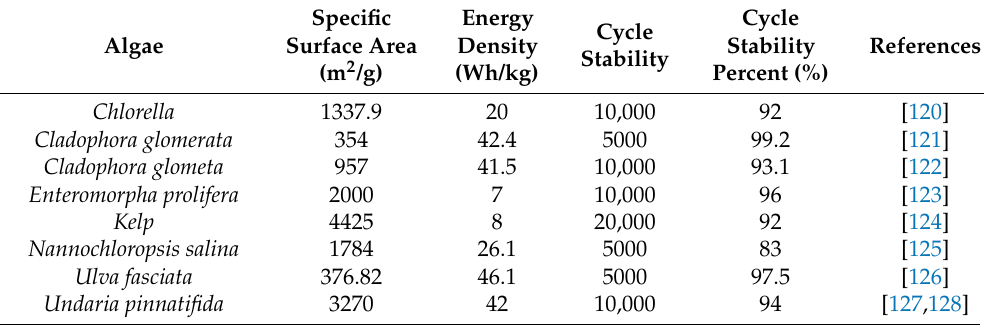
Table 7. The recent developments in supercapacitors derived from algal biochar. Specific Algae